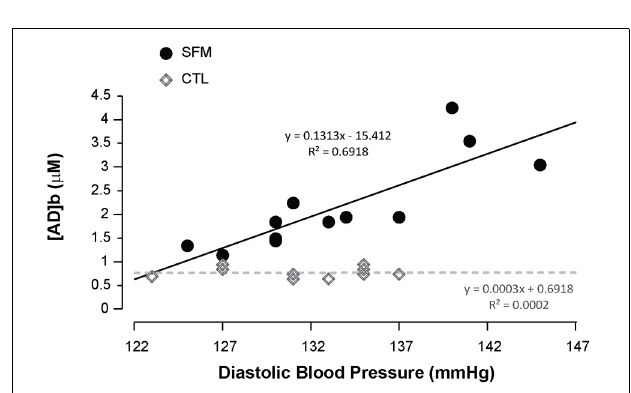
FIGURE 3 | Correlations between the systolic blood pressure recorded during the apnea and the blood adenosine concentration in spearfishermen (SFM) and control (CTL) subjects.